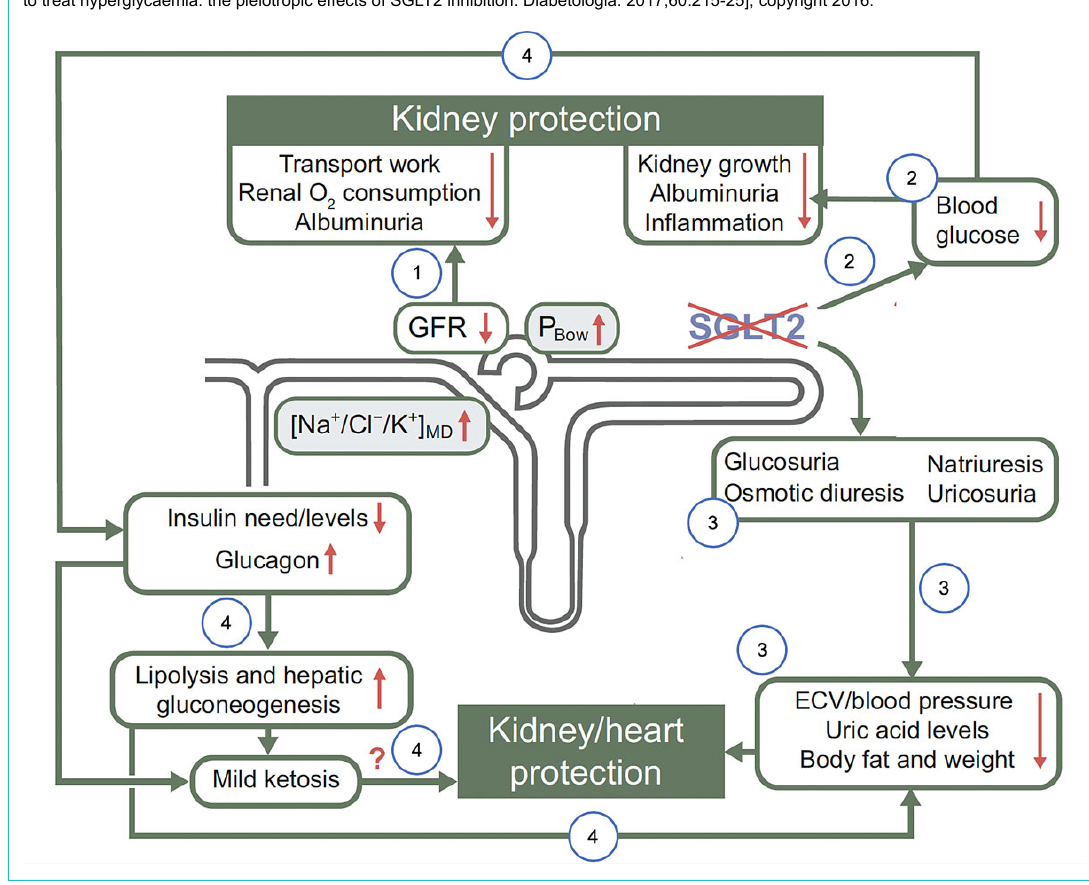
Figure 1: The pleiotropic effects of sodium-glucose cotransporter 2 (SGLT2) inhibition. SGLT2 inhibition may provide its cardioprotec- tive and renal protective effects via several pleiotropic mechanisms: (1) SGLT2 inhibition attenuates primary proximal tubular hyperreabsorp- tion in the kidney in diabetes, increasing/restoring the tubuloglomerular feedback signal at the macula densa ([Na + /Cl − /K + ]MD) and hydrostatic pressure in Bowman’s space (PBow). This reduces glomerular hyperfiltration, beneficially affecting albumin filtration and tubular transport work and, thus, renal oxygen consumption; (2) by lowering blood glucose levels, SGLT2 inhibitors can reduce kidney growth, albuminuria and in- flammation; (3) SGLT2 inhibitors have a modest osmotic diuretic, natriuretic and uricosuric effect, which can reduce extracellular volume (ECV), blood pressure, serum uric acid levels and body weight; (4) SGLT2 inhibition reduces insulin levels and the need for therapeutic and/or endogenous insulin, and increases glucagon levels. As a consequence, lipolysis and hepatic gluconeogenesis are elevated. These metabolic adaptations reduce fat tissue/body weight and hypoglycaemia risk, and result in mild ketosis, potentially having beneficial effects on both the renal and cardiovascular systems. White text boxes indicate affected variables; grey text boxes indicate processes that link SGLT2 inhibition to the reduction in glomerular filtration rate (GFR). Green arrows demonstrate consequences; red arrows indicate changes in associated vari- ables (increase/decrease). Reprinted by permission from Springer, Diabetologia, [Vallon V, Thomson SC. Targeting renal glucose reabsorption to treat hyperglycaemia: the pleiotropic effects of SGLT2 inhibition. Diabetologia. 2017;60:215-25], copyright